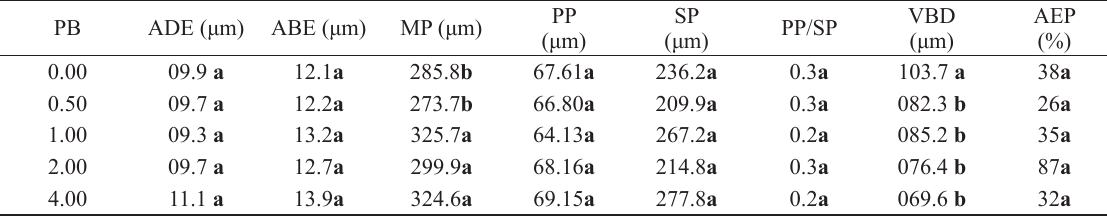
I Leaves quantitative anatomical characteristics in cross sections of water hyacinth ( Eichhornia crassipes ) grown under different lead concentrations (mg L -1